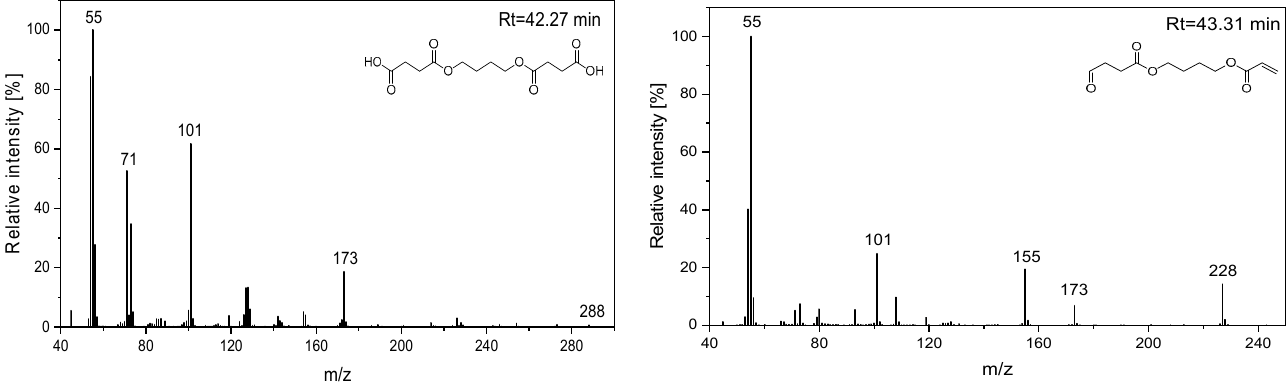
Figure 4. Mass spectra of major decomposition products of PBSu. Table 5. Thermal decomposition products of PHSu.